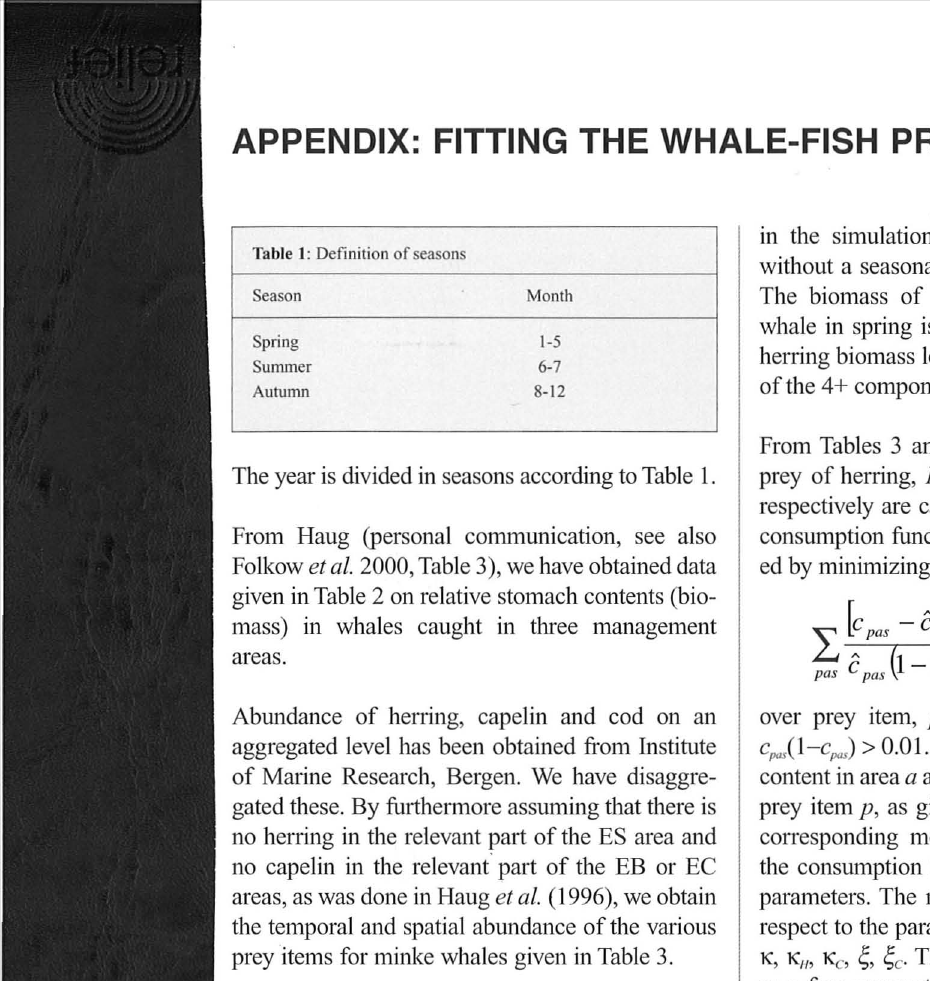
Table 2: Relative content in minke whale stomachs (percent). ES denotes west Spitzbergen and Bj0n10ya area, EB the management areas EB and EC, the Barents Sea and Coastal areas of the orwegian Sea. Source: Tore Haug, personal communication